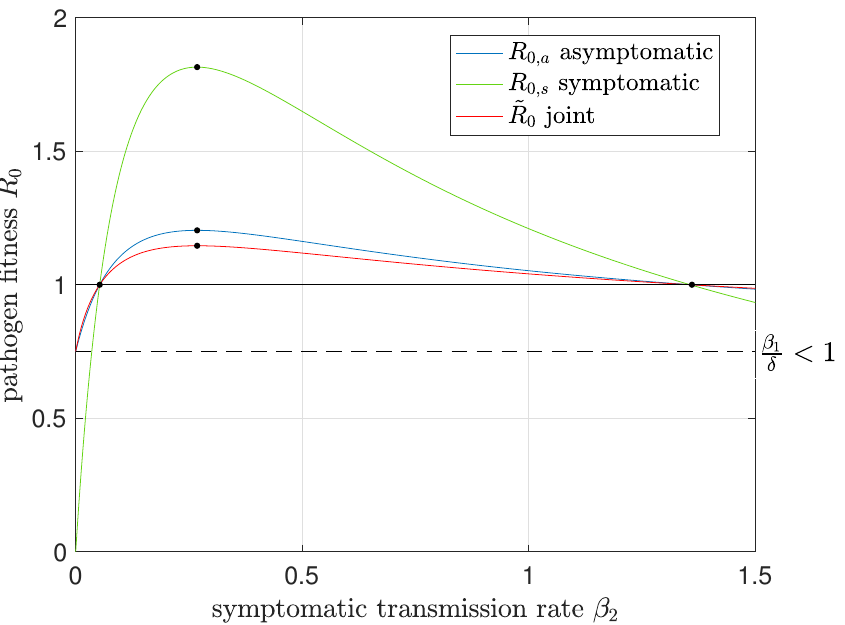
Figure 3. Basic reproduction number R 0 is computed for each transmission rate β 2 , from the asymp- tomatic, symptomatic and joint viewpoints, see (12)–(14), where virulence-transmission tradeoff (cid:16) β (cid:17) 2 1 + β 2 p is q γ = p · c , i.e., gains in transmission mean increasing virulence. Optimal values are 1 + p R ∗ = 1.2, R ∗ = 1.82 and ˜ R ∗ = 1.15 at the same point β ∗ 0, a 0, s 0 1/ δ = 4 days, β 1 / δ = 0.75 (dashed line), p = 0.7, q = 0.2 and c = 2.4 .